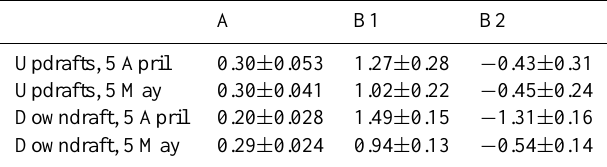
Fig. 12. Updrafts below cumulus clouds observed on 5 April 2006, in the early stage of the ABL evolution (top, 11:30–13:00LT) and close to its end (bottom, 14:30–16:00LT). Cloud base heights are indicated by black lines. The horizontal extent of the strong updrafts around 11:45, 12:22, and 12:53LT is 800–1000m, and the updraft mean velocity ranges from 1.6–2.4m/s. Peak velocity values in the updrafts frequently exceed 3m/s, sometimes 4m/s. In the afternoon less coherent updraft structures are observed below the